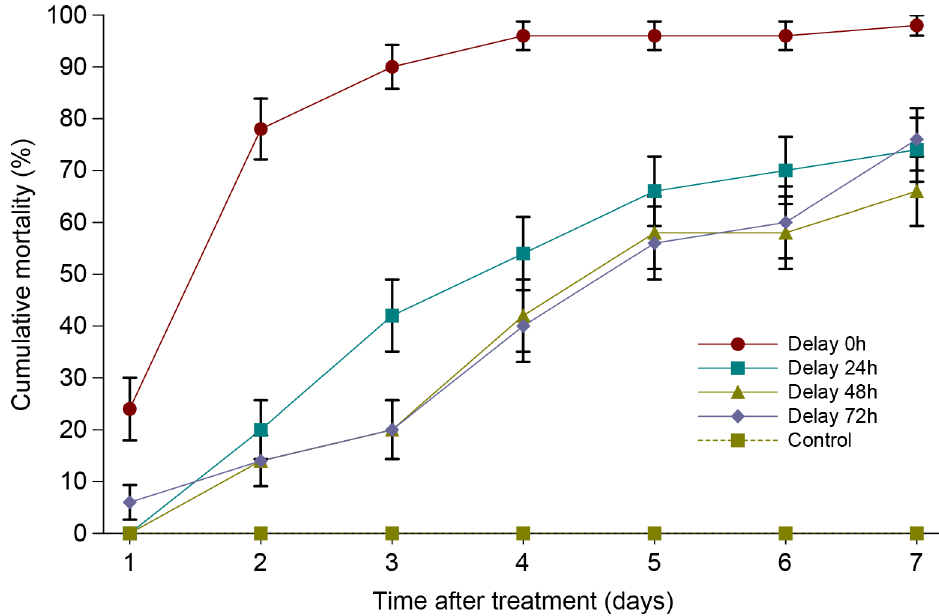
Fig 5. Cumulative mortality of L . decemlineata last-instar larvae treated by I . fumosorosea CCM 8367 in combination with S . feltia e. Vertical bars indicate standard